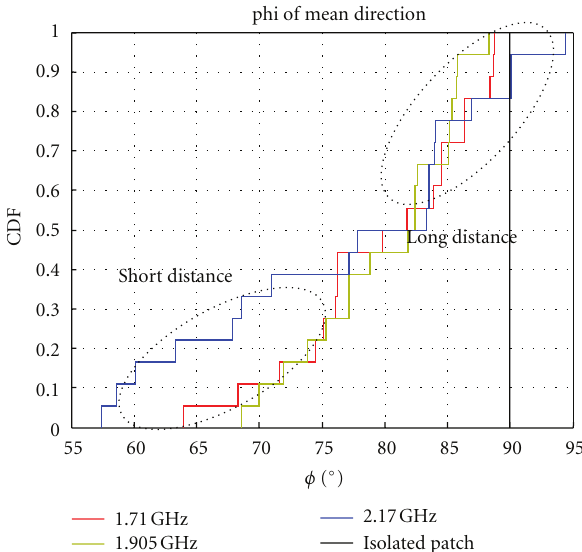
Figure 7: Distribution of the azimuth angle of the MRD for the patch-wall perpendicular case.